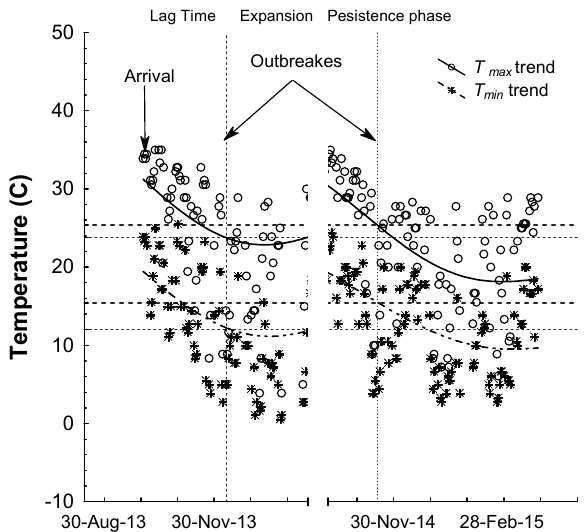
Figure 5. Daily data of maximum ( T max ) and minimum ( T min ) temperatures in °C from 9 October 2013 to 16 March 2015. During the lag time/expansion/persistence phases of N. tenuis . Daily T max (circle) and T min (asterisk) are shown. The moving mean curves were fitted by a distance-weighted least squares method of daily temperature trends for T max and T min . Lines with the intersection on the Y-axis show the values of temperature trend lines of two N. tenuis outbreaks in 2013 and 2014. Data are from the Climate Dataset, NOAA’s National Climatic Data Center (NCDC) of the station GHCND: USC00419588, Weslaco, TX, USA.